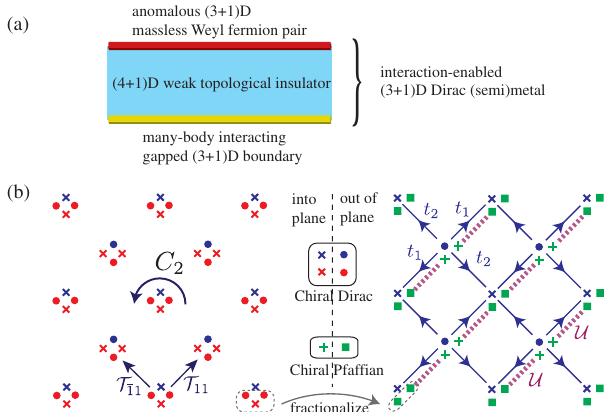
FIG. 19. (a) A quasi- ð 3 þ 1 Þ D interaction-enabled Dirac (semi) metal constructed by a 4D slab of WTI. (b) Coupled-wire model of an anomalous Dirac (semi)metal enabled by interaction with C 2 rotation and both AFTR T 11 ; T ¯11